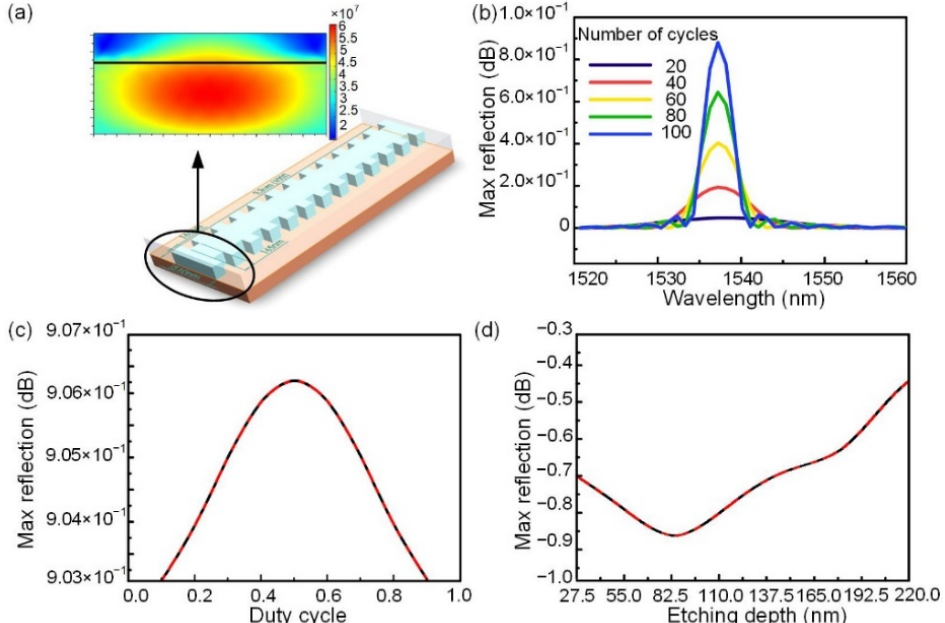
Figure 1. Characterization of two-sided WBG: ( a ) Schematic of two-sided WBG; ( b ) Maximum reflectivity of reflection spectrum of two-sided Bragg grating increases with number of periods; ( c , d ) Relationships between maximum reflectivity, and ( c ) duty cycle and ( d ) etching depth of two-sided Bragg grating.